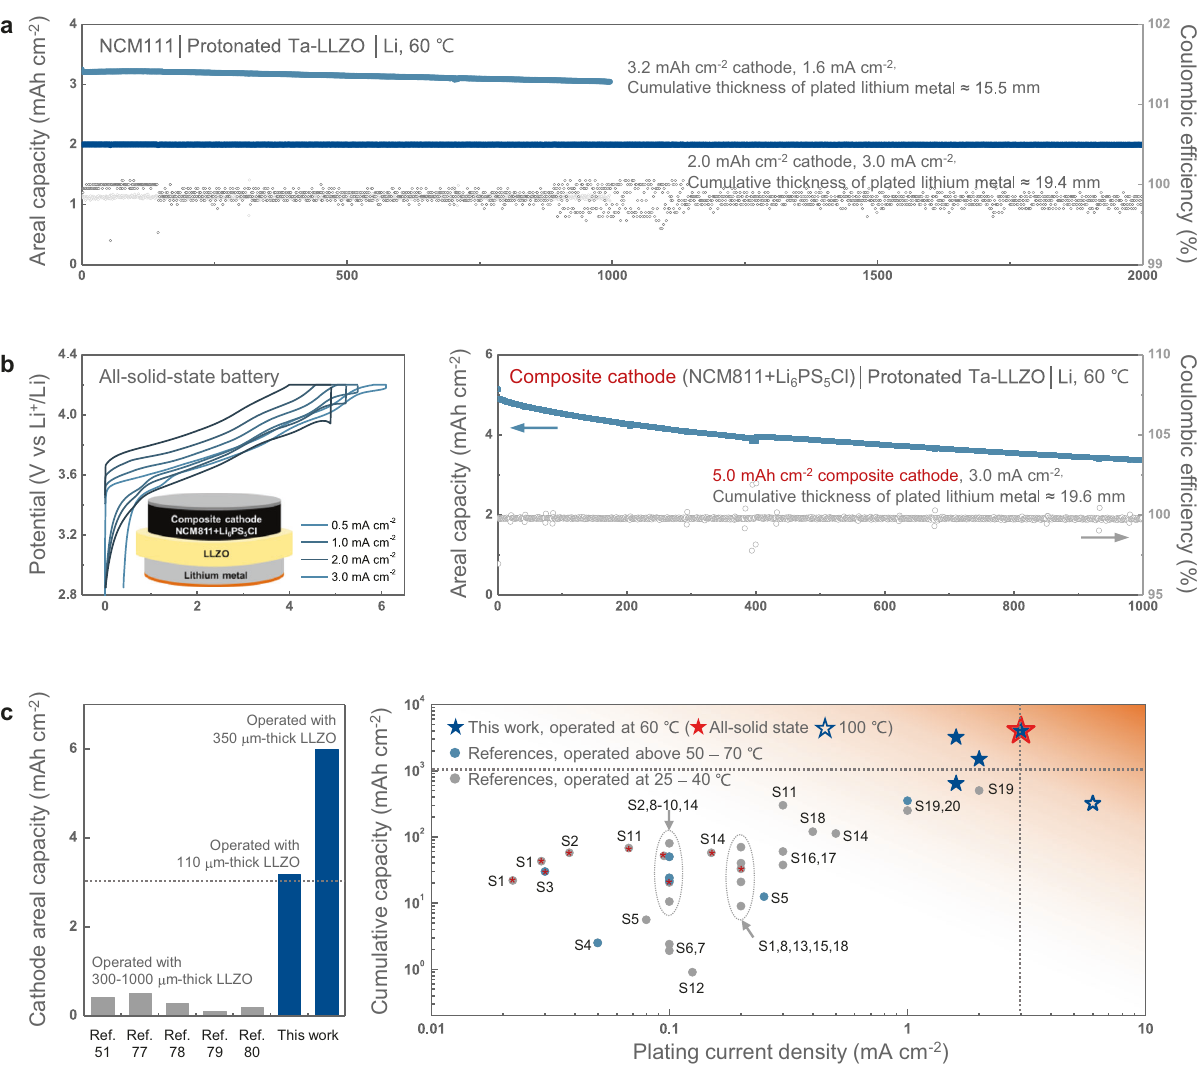
Fig. 4 Electrochemical performance of NCM111/protonated Ta – LLZO/Li hybrid cells. a Long-term cycling performance. The cells maintained remarkable cycling performance over 1000 and 2000 cycles, delivering 3.2 and 2.0 mAh cm – 2 , respectively, at an average Coulombic ef fi ciency over 99.83%, without signi fi cant capacity degradation or short-circuit failure. b Voltage pro fi les and long-term cycling performance of all-solid-state battery using a composite of NCM811 and Li 6 PS 5 Cl electrolyte as the cathode, showing a capacity of 5 mAh cm – 2 at 60 °C with doped, surface-tailored electrolytes. The cell successfully operated over 1000 times at a high current density of 3 mA cm – 2 without short-circuiting. c Performance comparison of solid ‐ state batteries using garnet- type solid electrolytes and Li-metal anodes. The left graph shows the cathode capacity of full cells studied previously 51,77 – 80 in comparison with the cells of the surface-stabilised Ta – LLZO electrolyte. The right plot summarises the current density and cumulative areal plating capacity at several